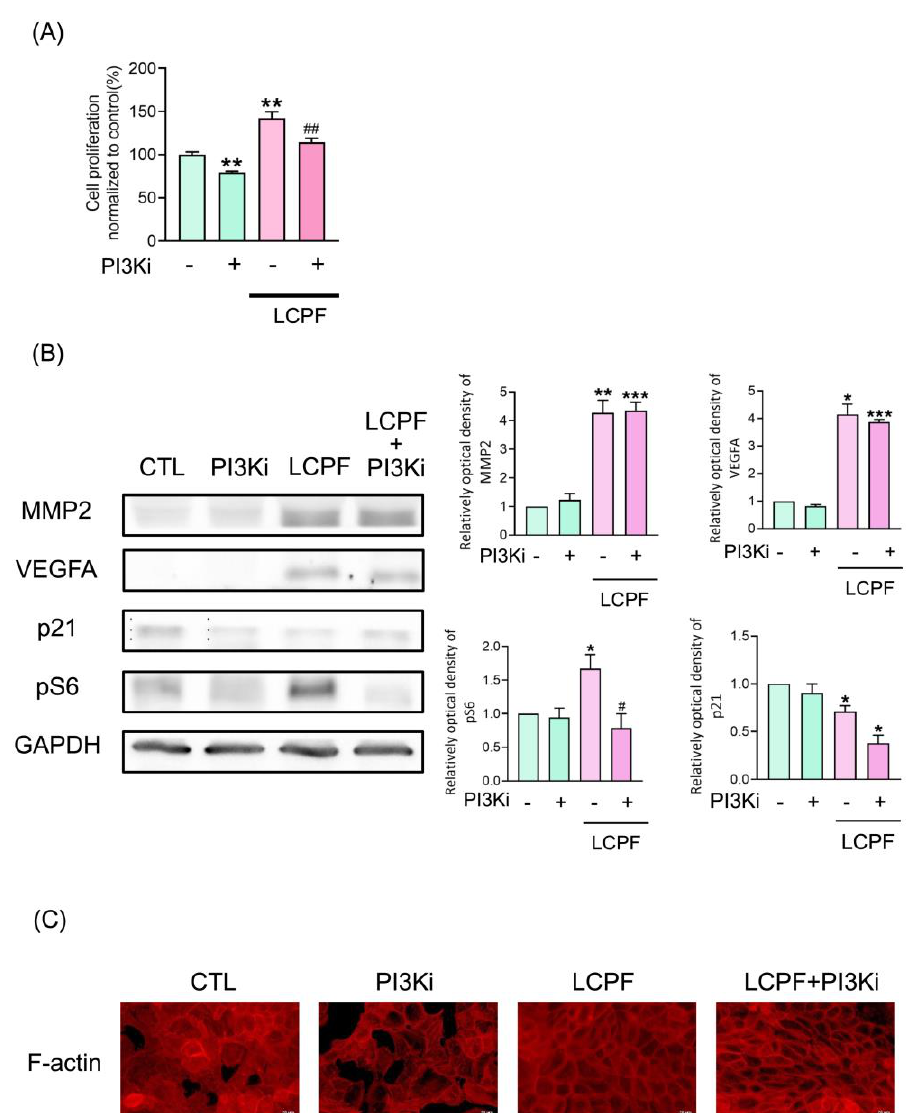
Figure 5. p -PI3K inhibitor restores LCPF-induced keratinocyte proliferation but not MMP2, VEGFA expression, and epidermal junction rearrangement. HaCaT was treated with or without 10 µM of p -PI3K inhibitor, LY294002, in the presence of LCPF for 24 h. ( A ) Cell viability was determined using an MTT assay. ( B ) MMP2, VEGFA, p21, and pS6 protein expression was examined via Western blot analysis. ( C ) The cells were then subjected to F-actin staining (red). Scale bar = 40 µm. * p < 0.05; ** p < 0.01; *** p < 0.005compared to the control group. # p < 0.05; ## p < 0.01 compared to the LCPF group.